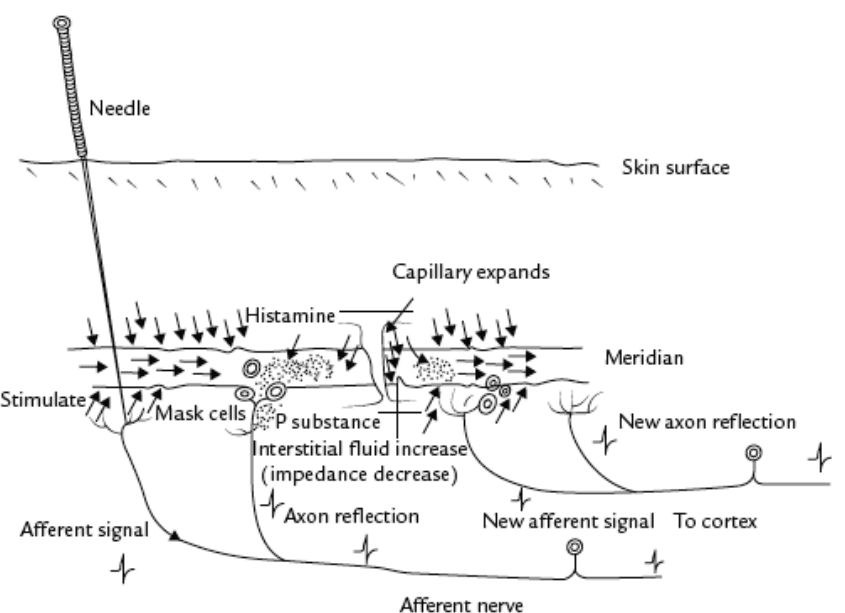
Figure 8. Proposed mechanism for the effect of acupuncture along meridians. Reprinted with permission from ref. [86]. Copyright 2010 Elsevier (Amsterdam, The Netherlands) and Copyright Clearance Center (Danvers, MA, USA).